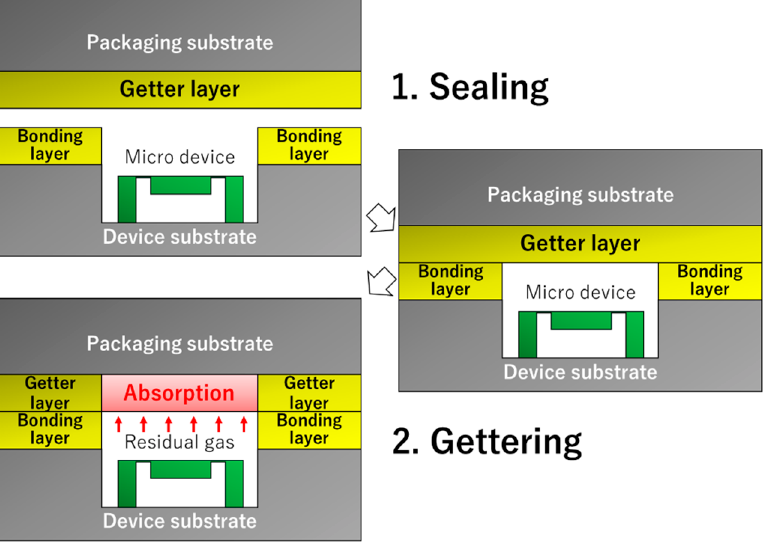
Figure 1. Simplified vacuum packaging process using direct bonding of getter layer.